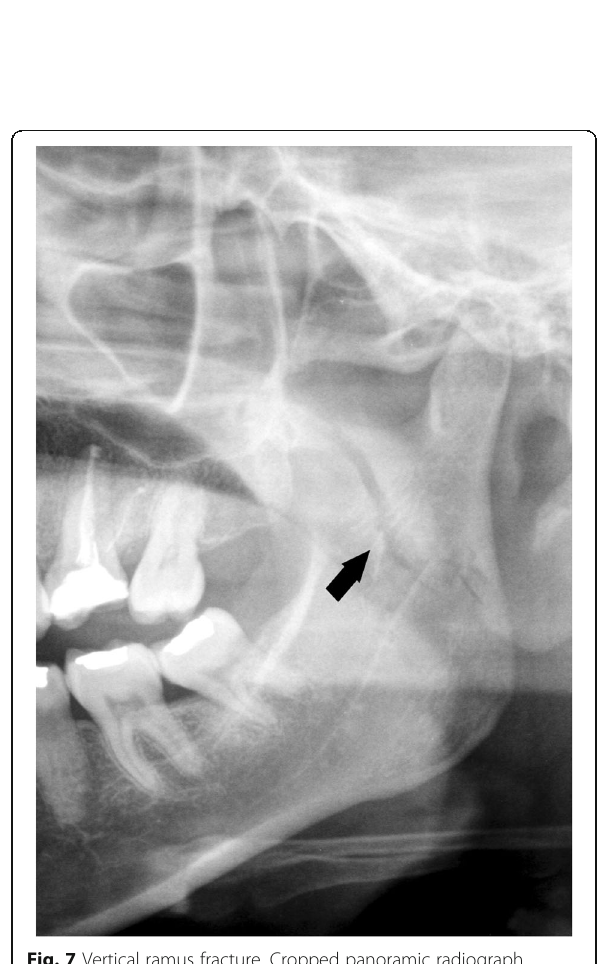
Fig. 7 Vertical ramus fracture. Cropped panoramic radiograph showing a fracture of the left mandibular ramus, which runs from the external face of the ramus to the sigmoid notch